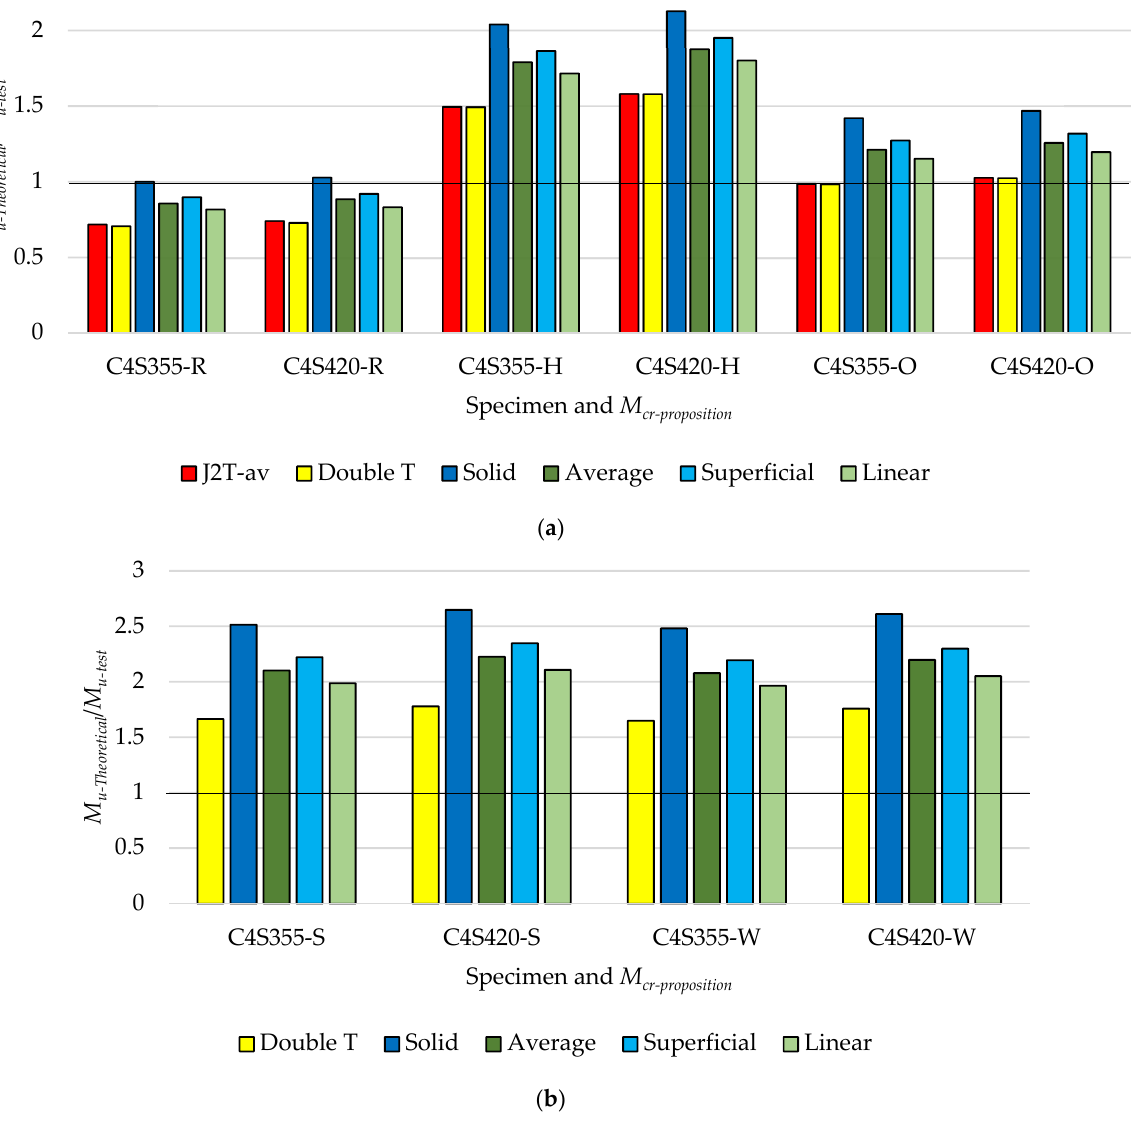
Figure 20. Accuracy obtained by the Salah’s M u proposition [58] for composite cellular beams: ( a ) M cr calculation based on the U-frame model; ( b ) M cr calculation proposed by Svensson [121] and Williams and Jemah